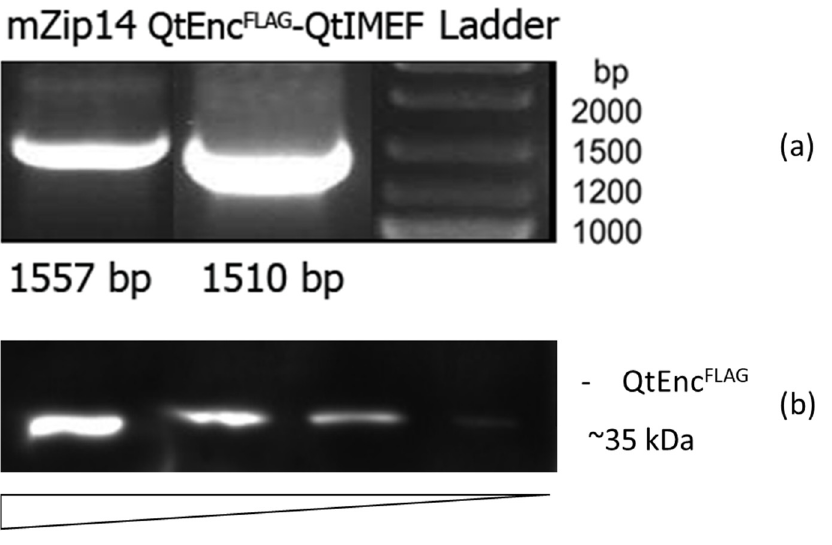
Figure 1. ( a ) RT-PCR analysis of 4T1-Qt cells; ( b ) Western blot analysis against FLAG-tag on Q.thermotolerans encapsulin protomer proteins in 4T1-Qt cells.